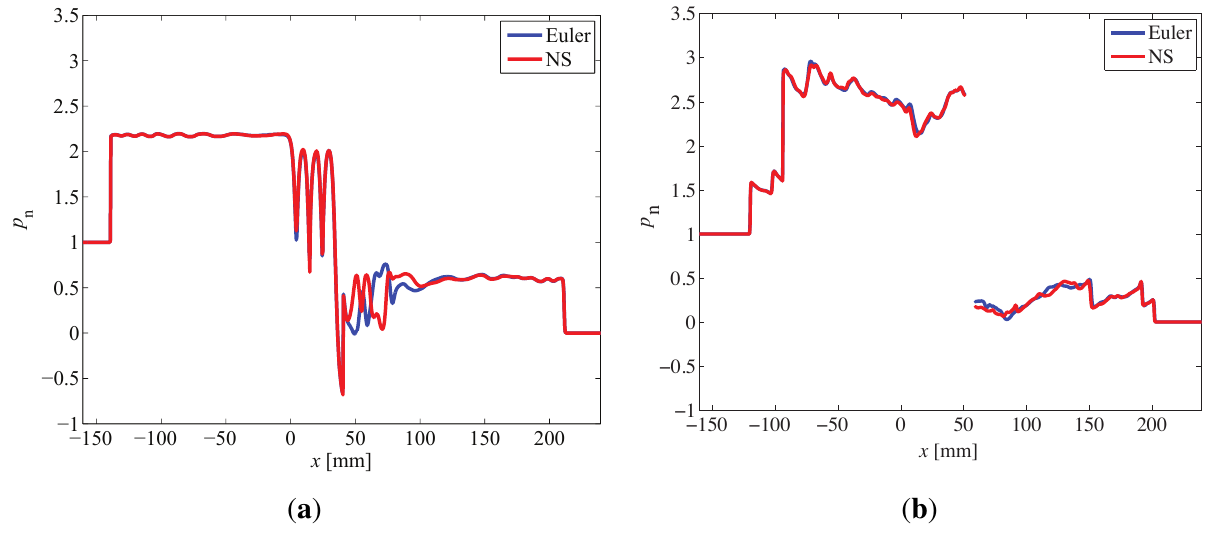
Figure 5. Dimensionless pressure, p , along the centerline for Navier–Stokes and Euler n simulations at time instant t = 500 µ s for non-staggered cylinders (NC) and logarithmic spiral squares (LSS). ( a ) NC; ( b )